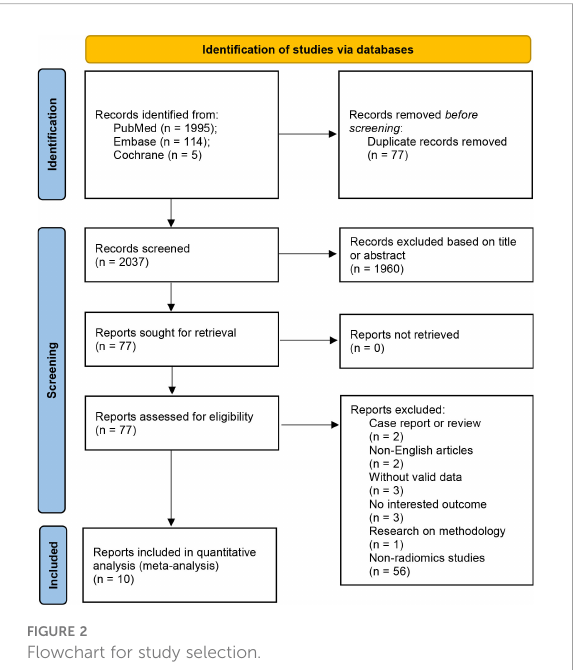
FIGURE 2 Flowchart for study